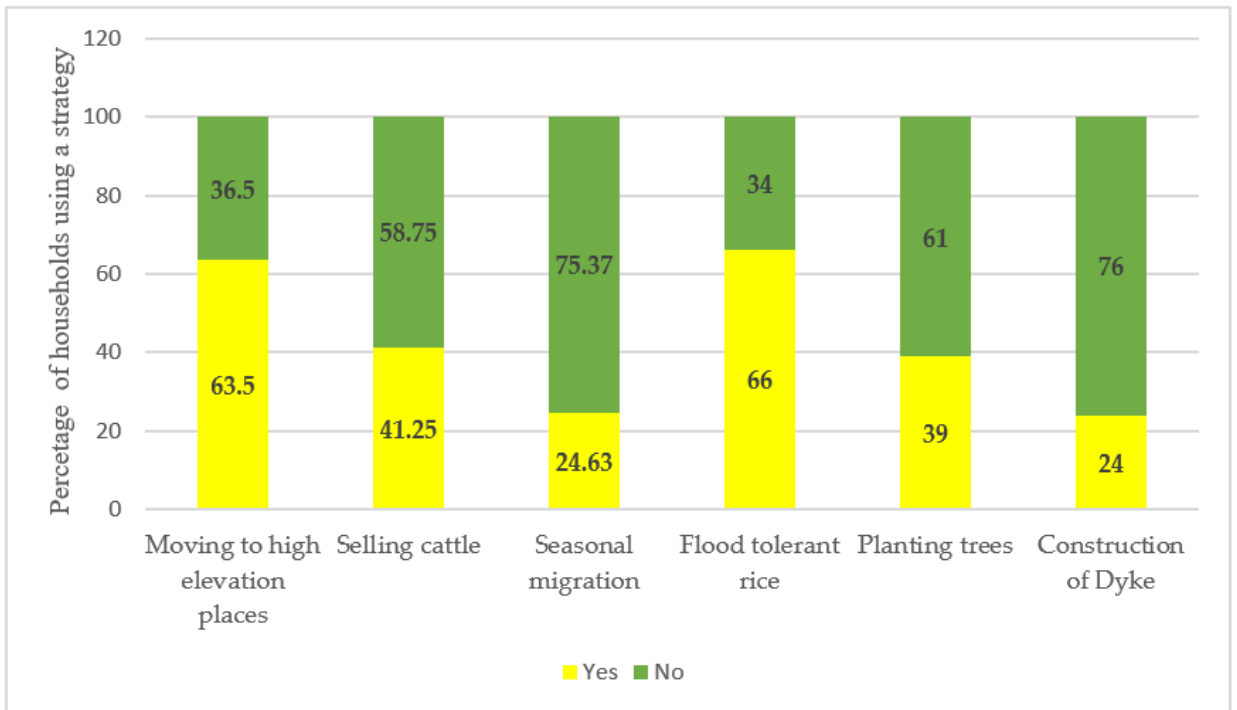
Figure 3. The Common Adaptation Strategies in the Study Area. Source: Household Survey, May 2022.